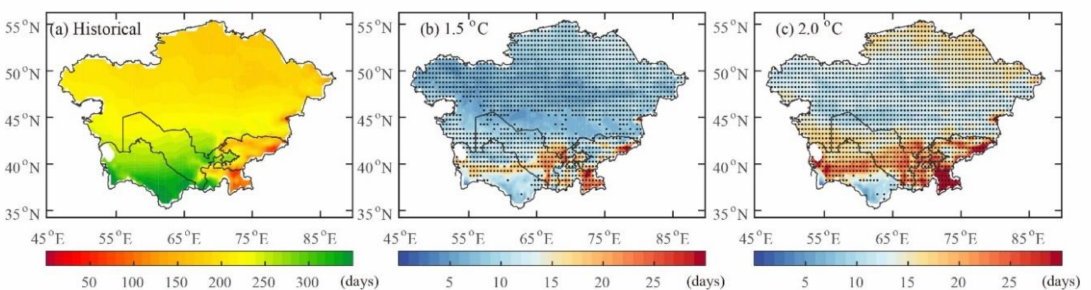
Figure 5. The spatial distribution of the growing season length (GSL) in the reference period (1986–2005) ( a ) and the di ff erence under 1.5 ◦ C ( b ) and 2 ◦ C ( c ) global warming relative to the reference period. Dark gray dots indicate that the increasing trends are significant at the 1% level in these grids.